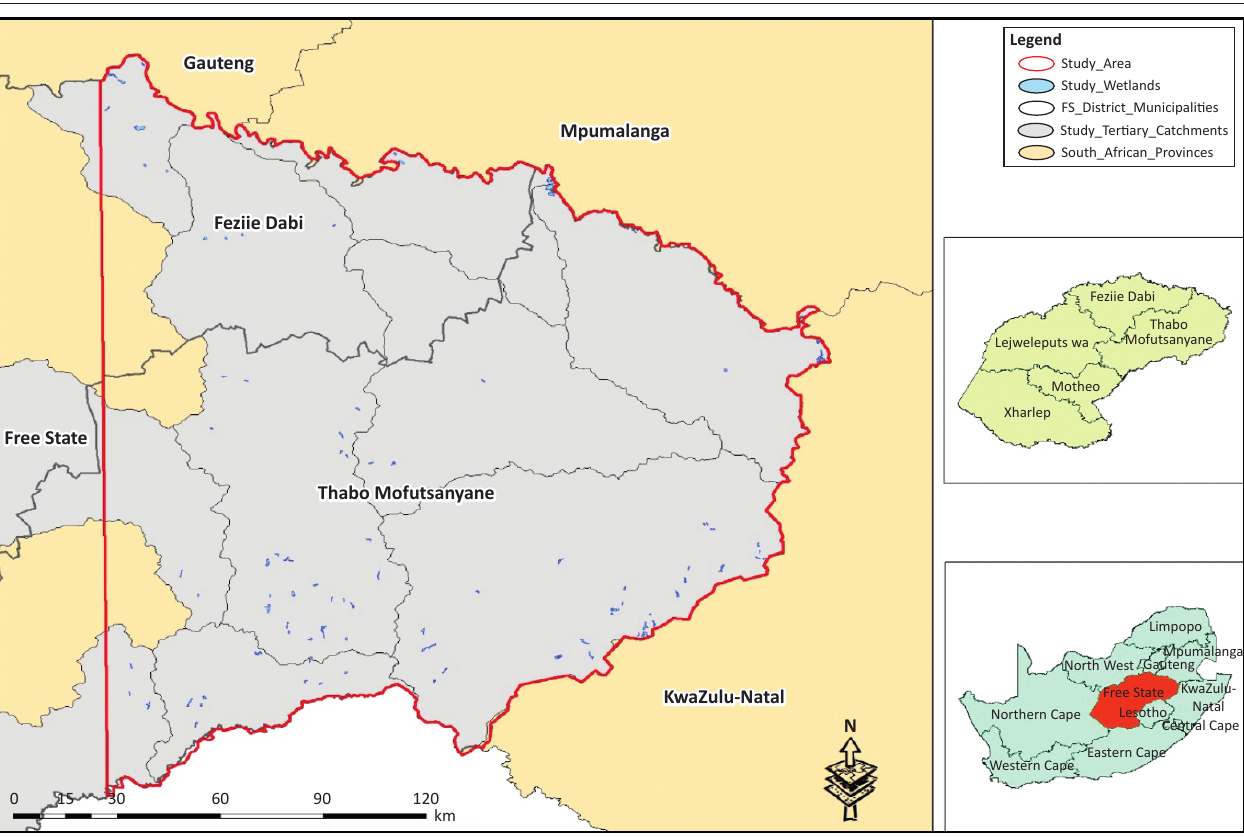
FIGURE 1: The eastern Free